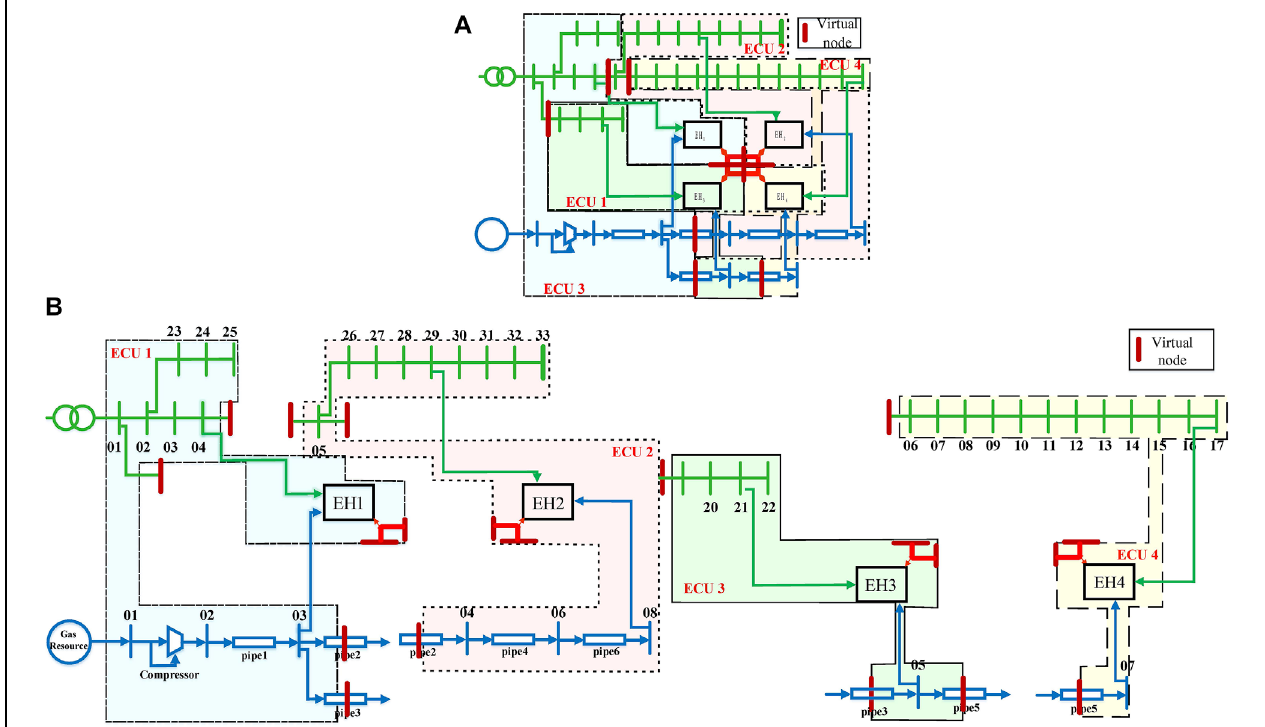
FIGURE 8 | MRIES partition based on ECU. (A) Overall partition of MRIES. (B) Partition details of MRIES.